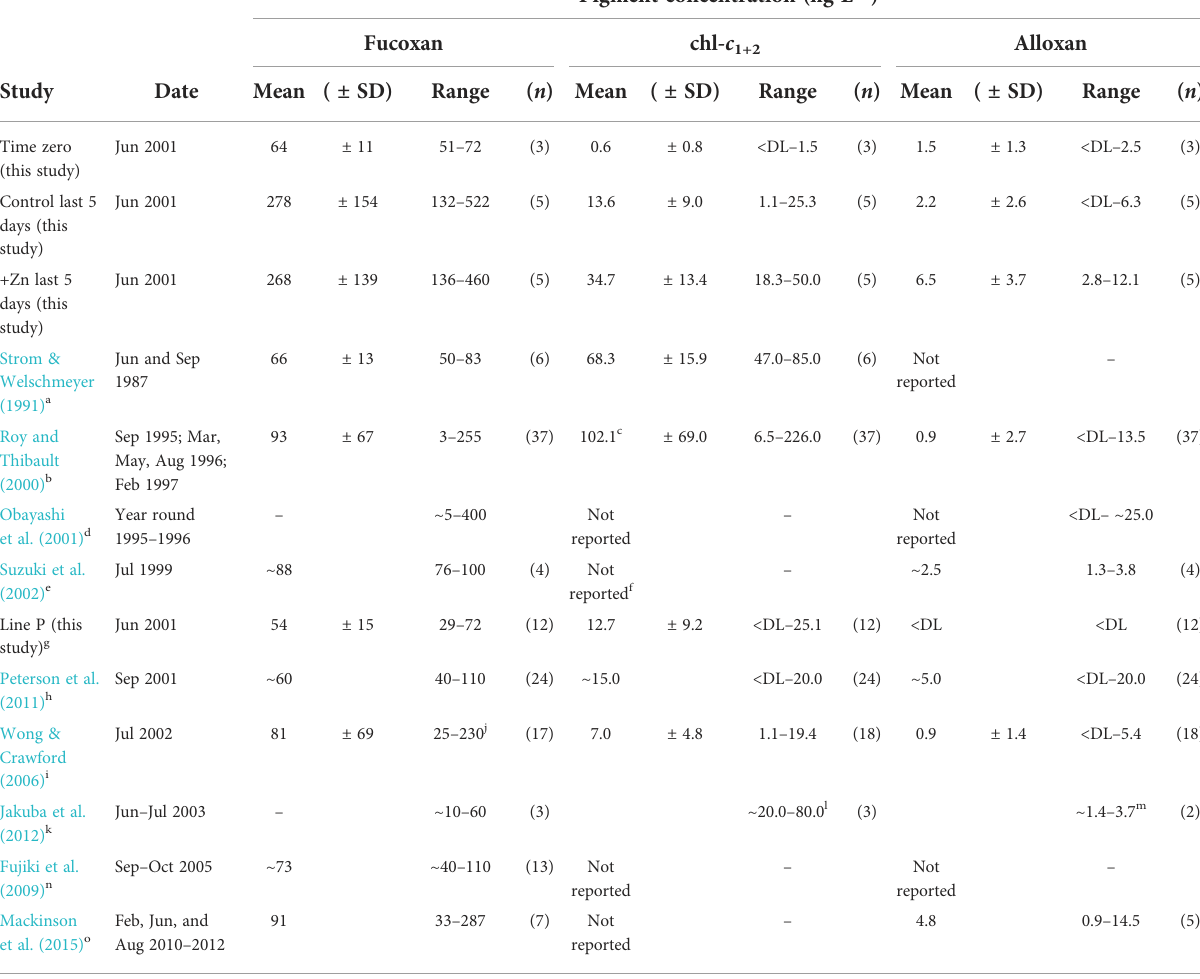
TABLE 3 Summary of observed published concentrations of fucoxanthin, chlorophyll c 1+2 , and alloxanthin in the Northeastern Subarctic Paci fi